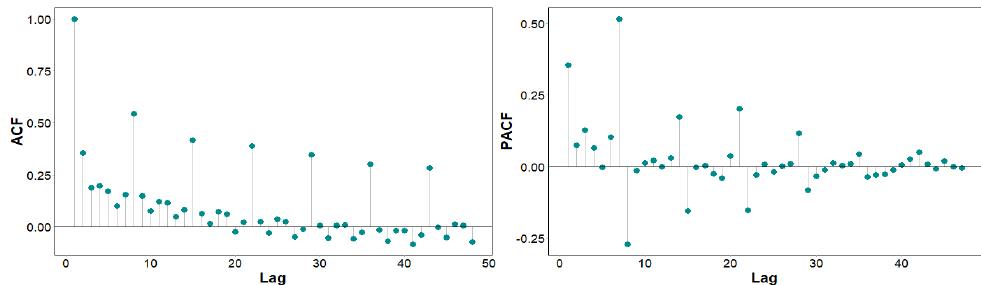
Figure 5. Autocorrelation residuals of non-spatial GAM.